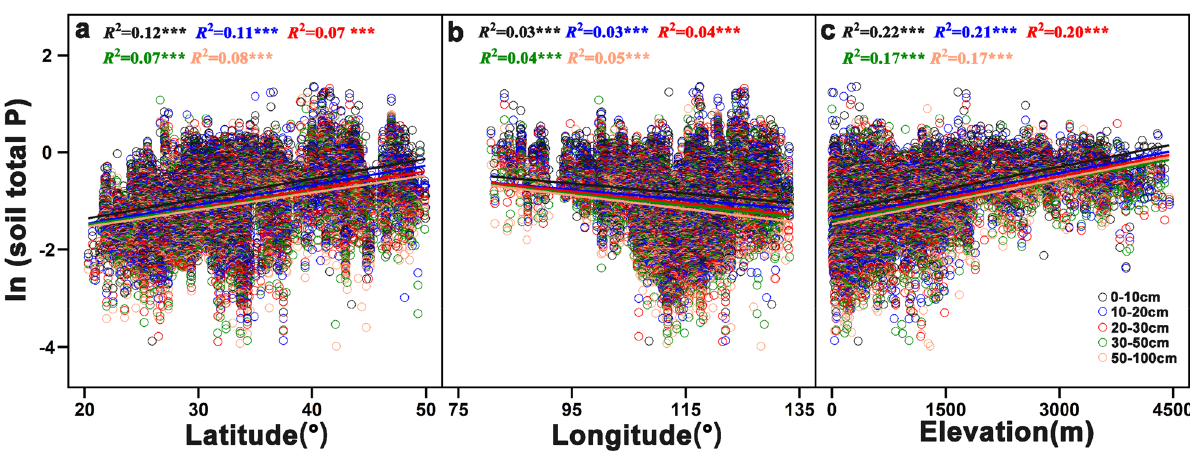
Figure 4. Change in soil total P in China’s forest ecosystems along the latitudinal ( a ), longitudinal ( b ), and elevation ( c ) gradient. *, p < 0.05; ** p < 0.01; *** p <